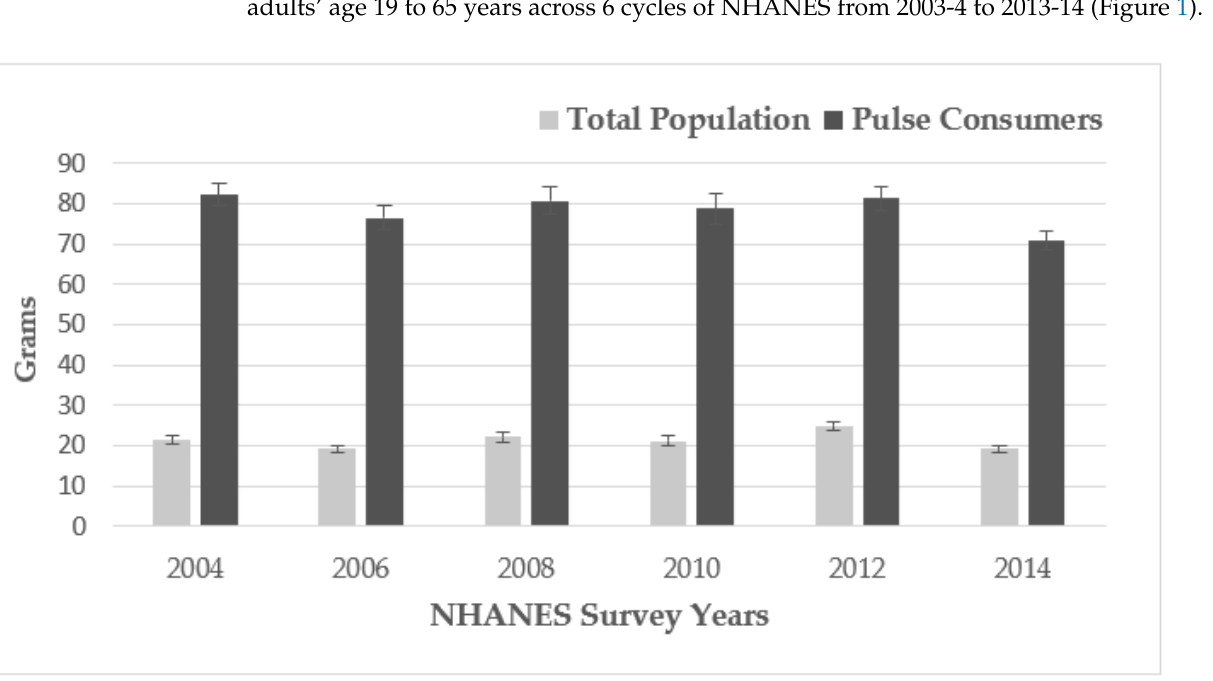
Figure 1. Pulse intake (grams) in the total population vs. pulse consumers, adults ≥ 19 years of age, National Health and Nutrition Examination Survey (NHANES) 2013–2014.